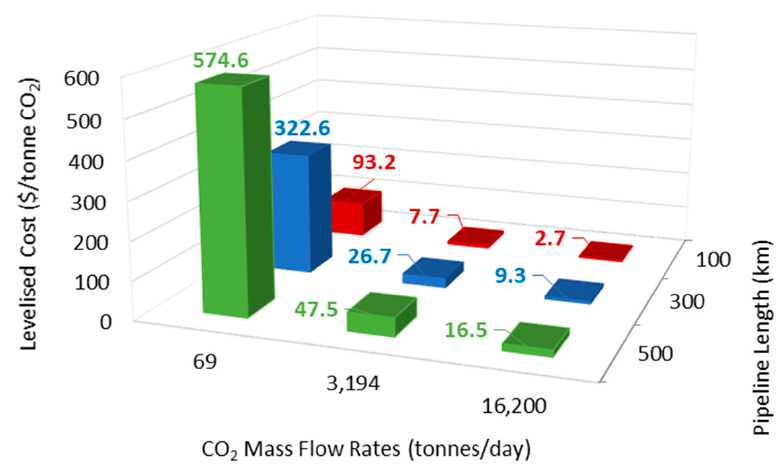
Figure 5. Levelized cost of CO 2 transport as a function of CO 2 mass flow rate and pipeline length.